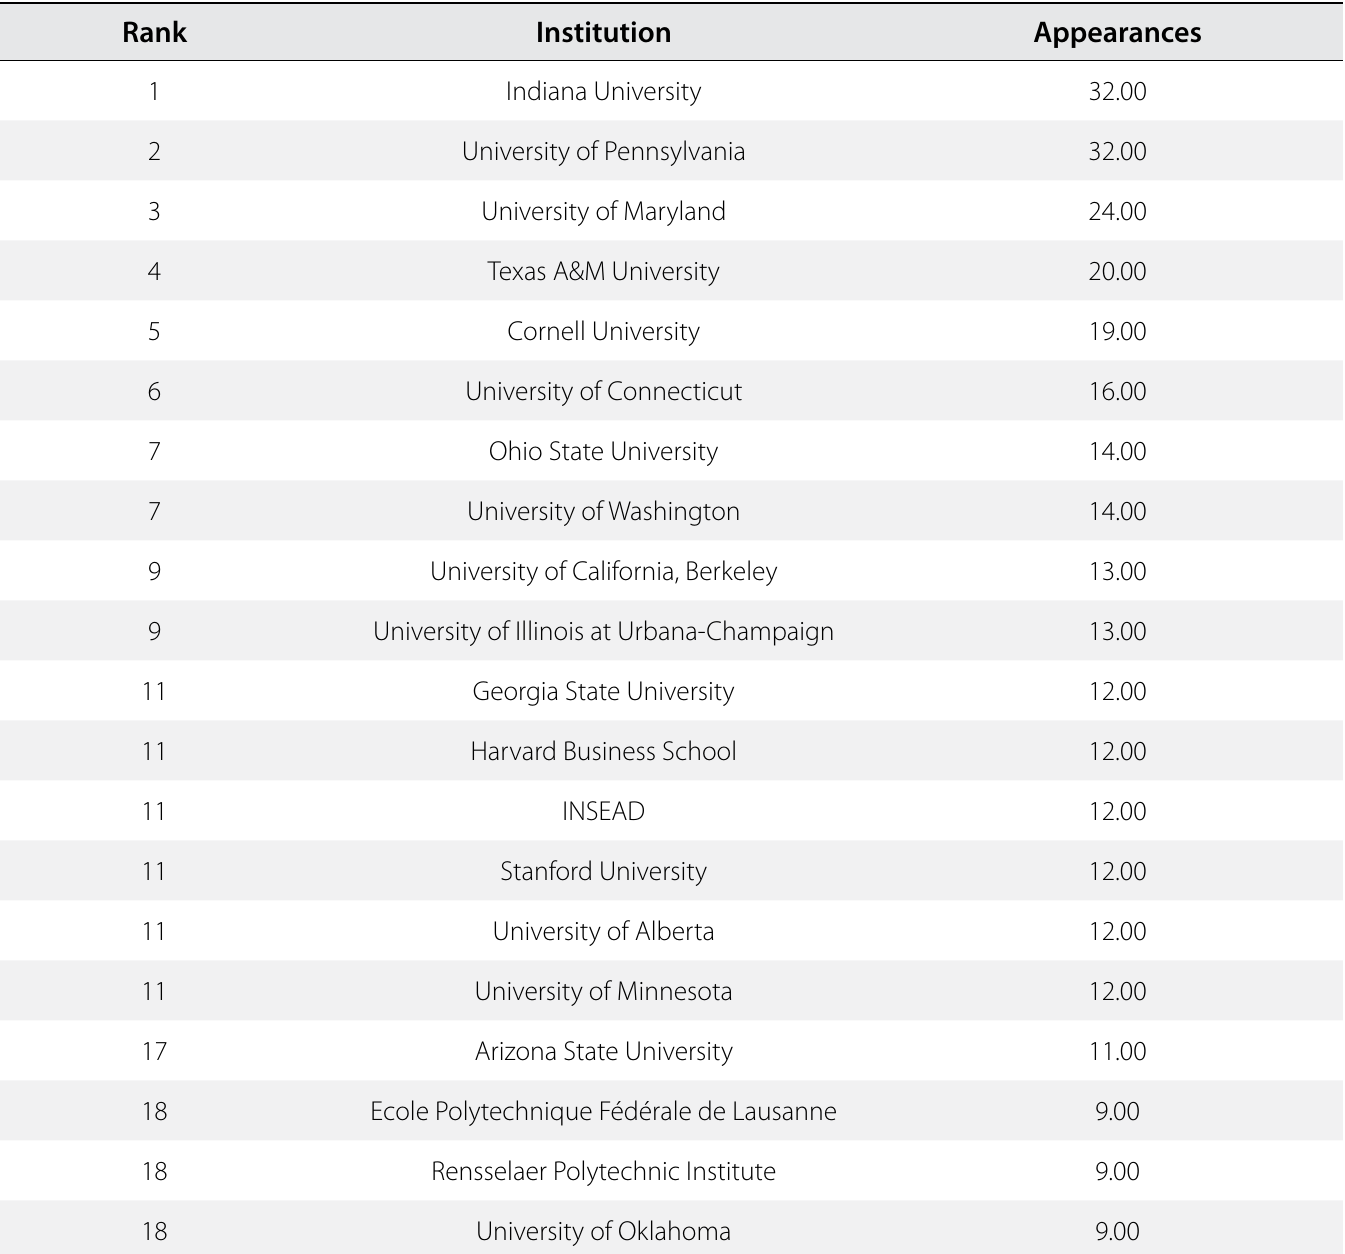
Table 8. Top Institutions Ranked by Appearances